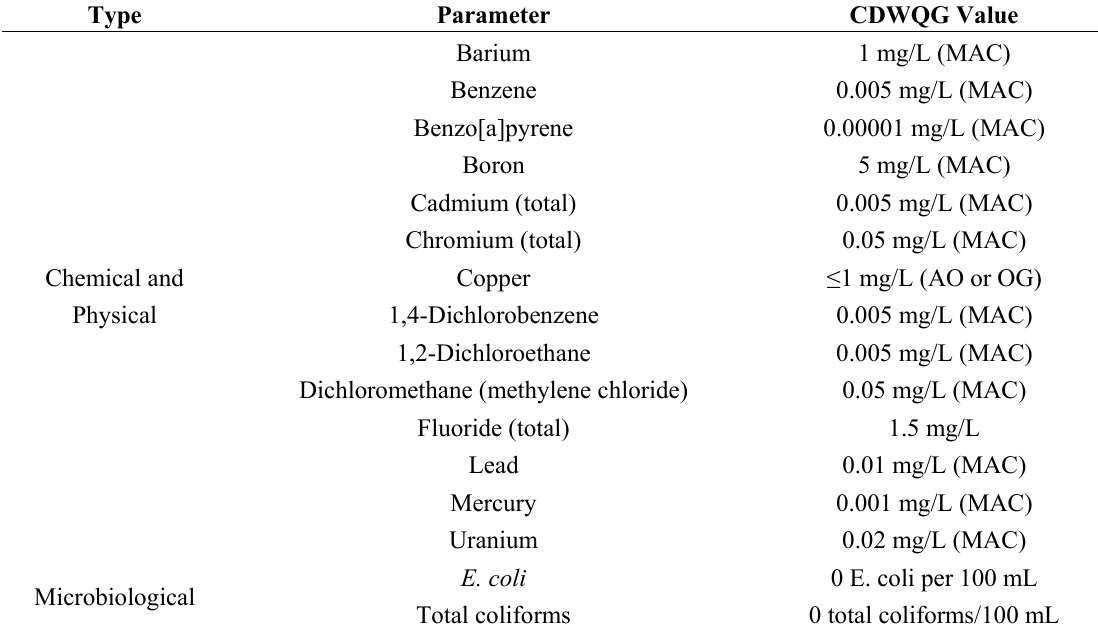
Table 3. Canadian Drinking Water Quality Guidelines—the common baseline.